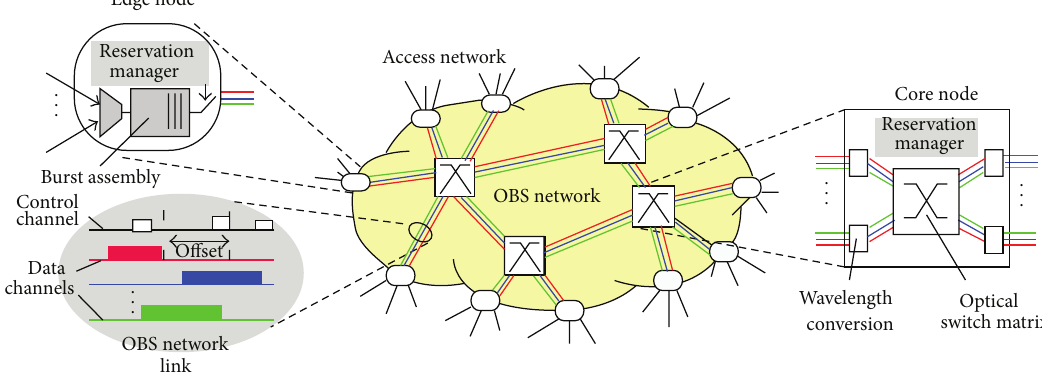
Figure 1: OBS architecture [7]. Courtesy: Gauger et al.